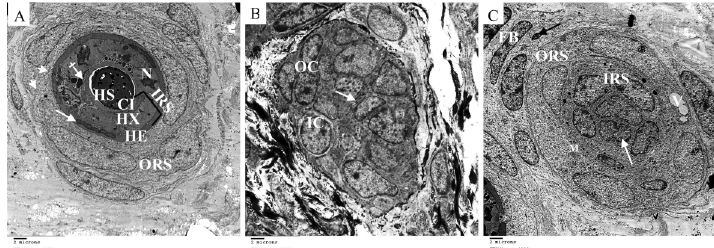
Figure 6. Electron micrographs of hair follicles of neonate rabbits ( (cid:1) 4000, scale bar 2 m m). A , Control group showing mostly terminal stage hair follicle with hair shaft (HS) in the center surrounded by the three layers of inner root sheath (IRS) forming its cuticle (CI), Huxley ’ s layer (HX) with its degenerated nucleus (N) and trichohyalin granules (crossed arrow), and corni fi ed Henle ’ s Layer (HE) with degradation of its nuclei (white arrow), surrounded by the outer root sheath (ORS) with intact mitochondria (arrow-head). B and C , Constant light group showing: B , immature hair follicle (mostly stage 2) before papilla intrusion formed of inner cells (IC) and outer cells (OC). Notice the tono fi lament-like structures (arrow) formed by inner cells; C , mostly fourth stage hair follicle formed by inner root sheath (IRS) with a shrunken indented nucleus (white arrow), outer root sheath (ORS) with vacuolation (V) and swollen mitochondria (M), and surrounding fi broblasts (FB) with some apoptotic nuclei (black